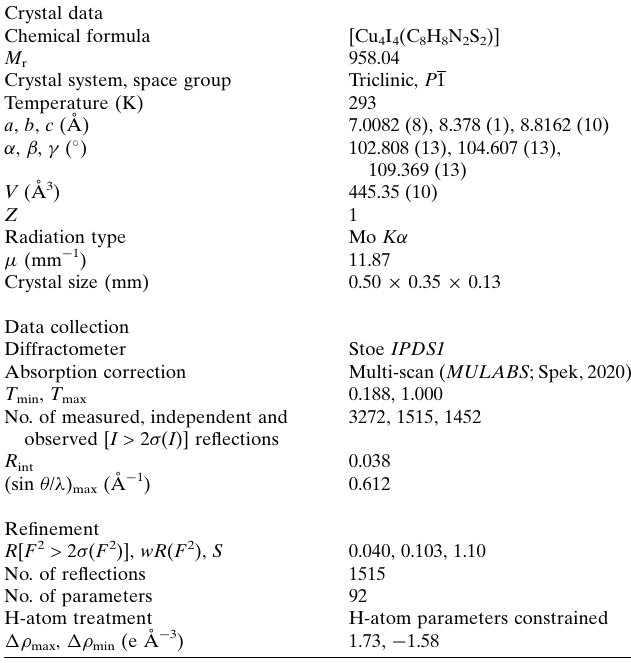
Crystal data Chemical